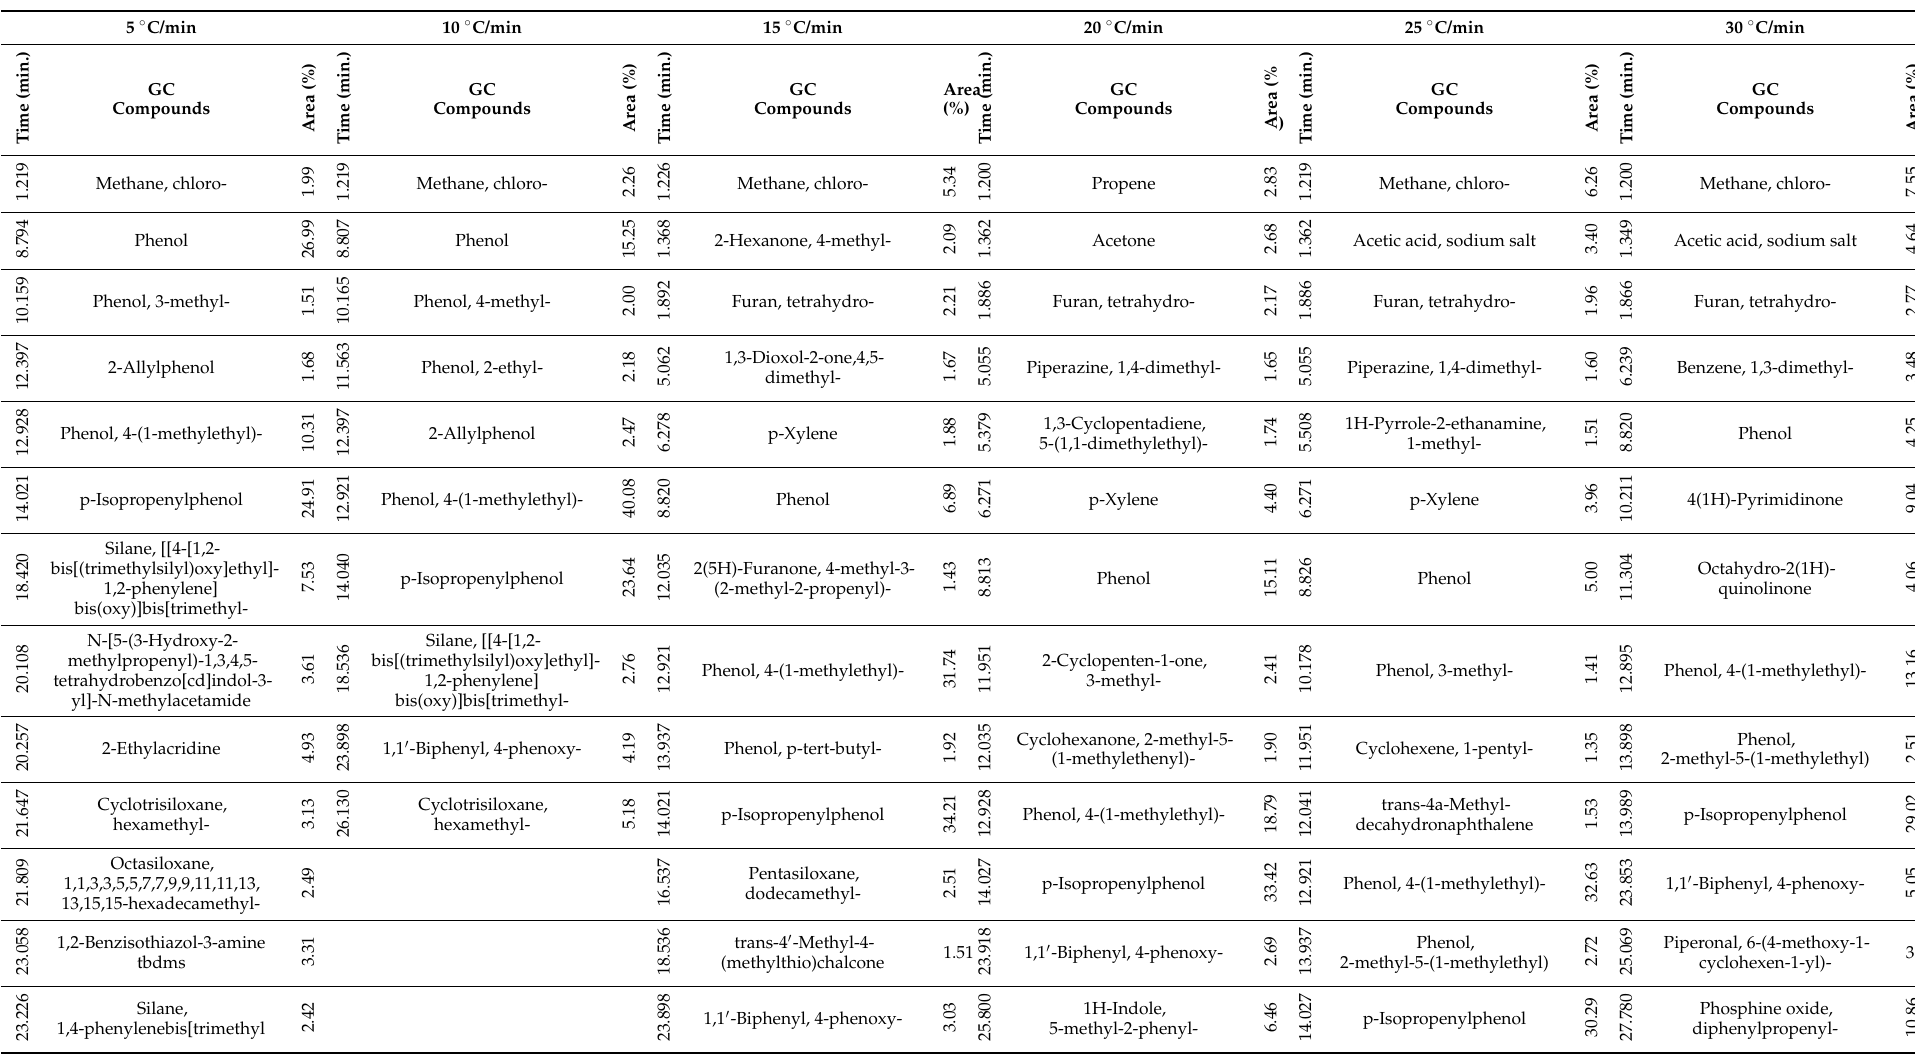
Table 4. GC-MS compounds generated at 5–30 ◦